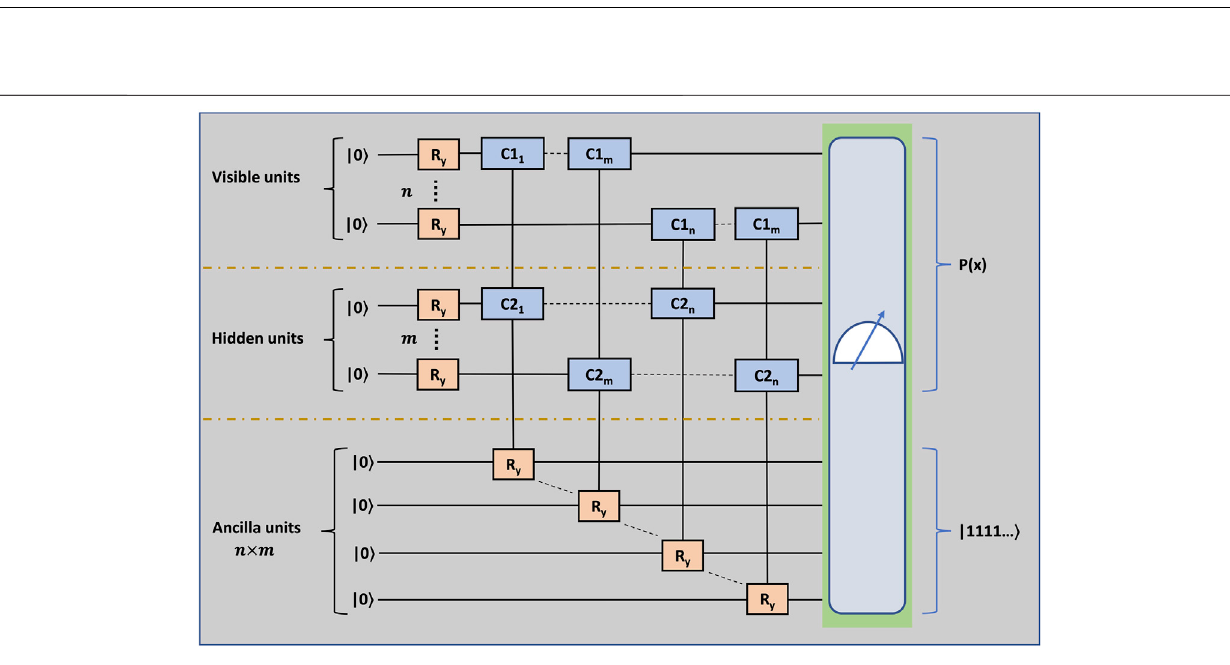
Frontiers in Physics |